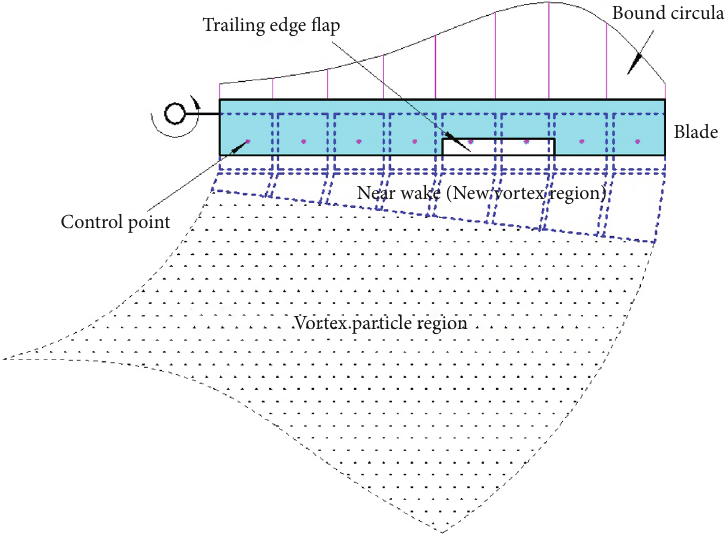
Figure 1: Solution diagram of the vortex lattice bound to the ECR blade surface and new vortex particle.